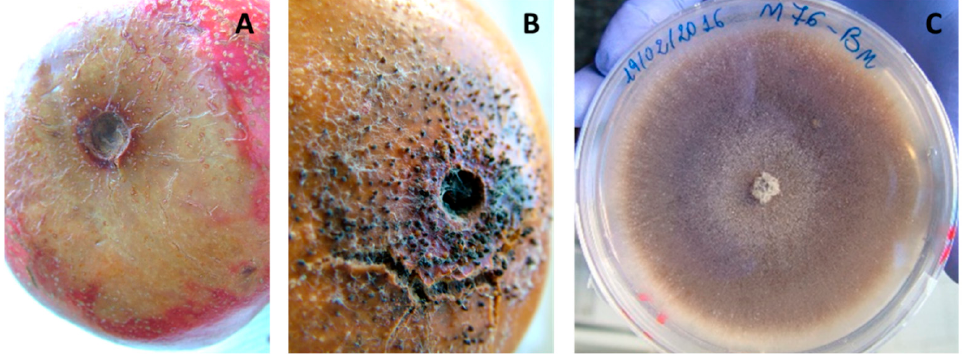
Figure 9. Artificial infections caused by Cytospora punicae on pomegranate fruit: ( A ) rot symptom, ( B ) close ‐ up of soft rot showing pycnidia. ( C ) Colony on PDA plate. ( B ) close-up of soft rot showing pycnidia. ( C ) Colony on PDA